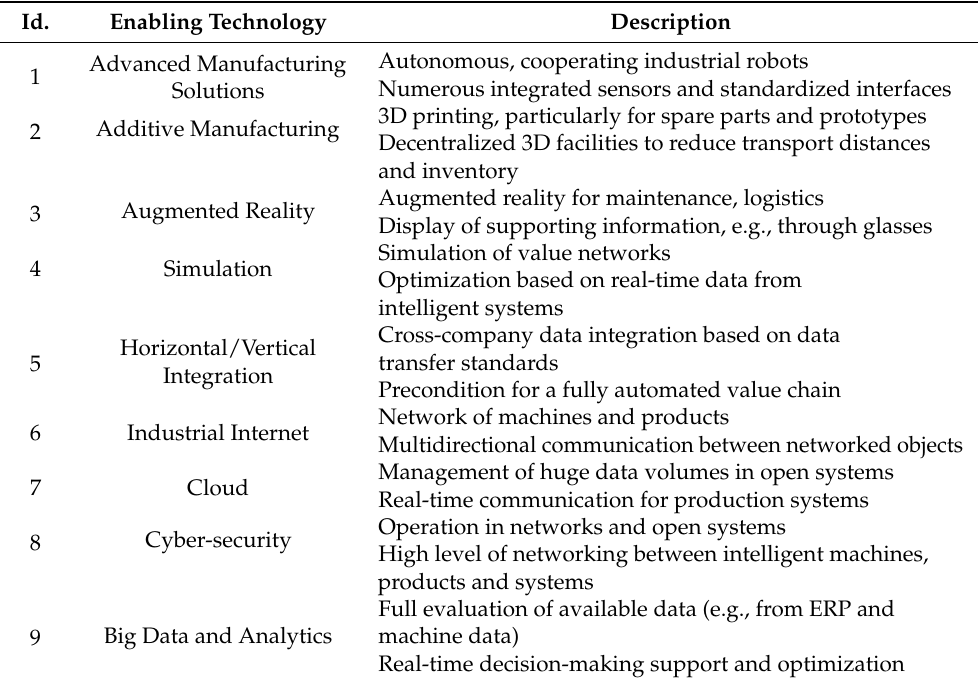
Table 1. Industry 4.0 enabling